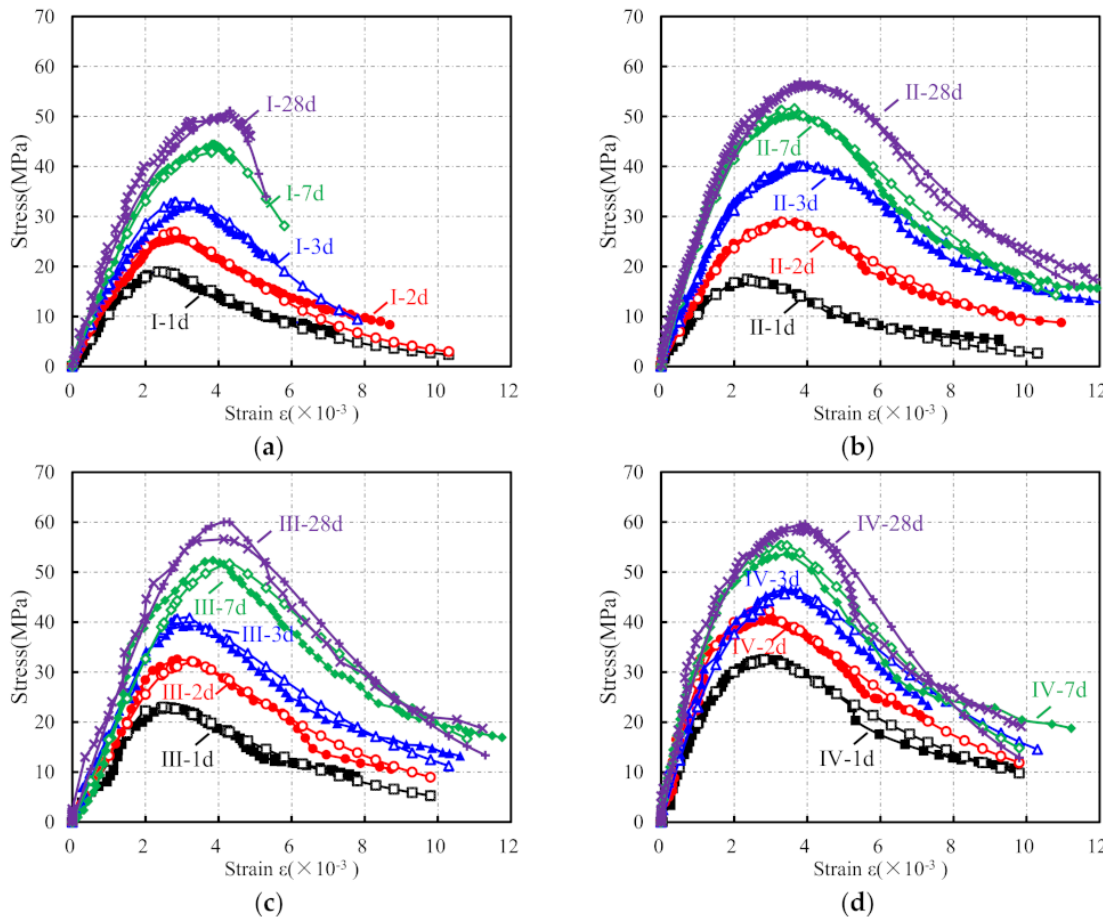
Figure 16. Comparisons between calculated curves from the proposed model and test results of ( a ) CGM − 380; ( b ) CGM − 340; ( c ) CGM − 300; and ( d ) CGM −